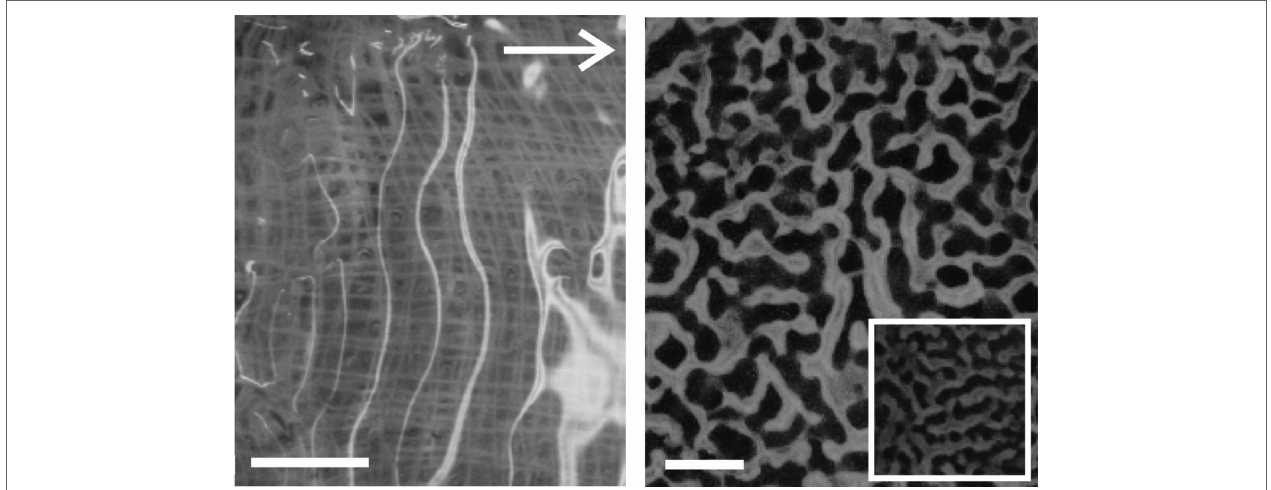
FIGURE 6 | Examples of Kinneyia-like structures generated in the laboratory from viscoelastic films of PVA . The white arrow indicates the direction of flow for both images. Scale bars are 10mm. Left : without any sediment added (The gauze, which was used as a substrate to graft the PVA layer, is visible through the clear film). The rippled surface is revealed by the bright reflections from the light source. Right : with a powder consisting of small ( (cid:25) 100 (cid:22) m diameter) glass spheres added to mimic sedimental freight of the water flow. The inset shows some part of the sample from the outer regions of the sample where the PVA layer was thinner.